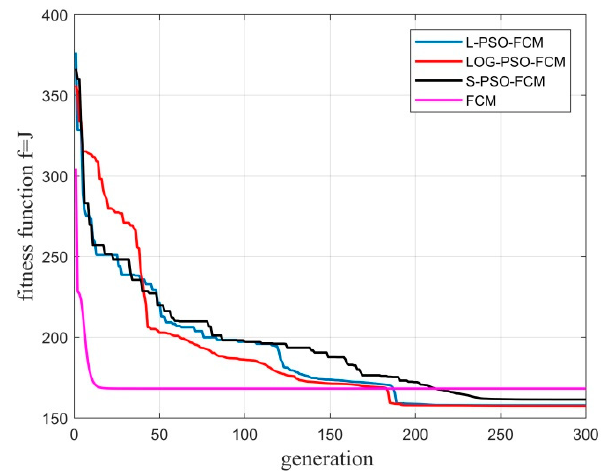
Figure 6. Fitness curves for 300 generations.